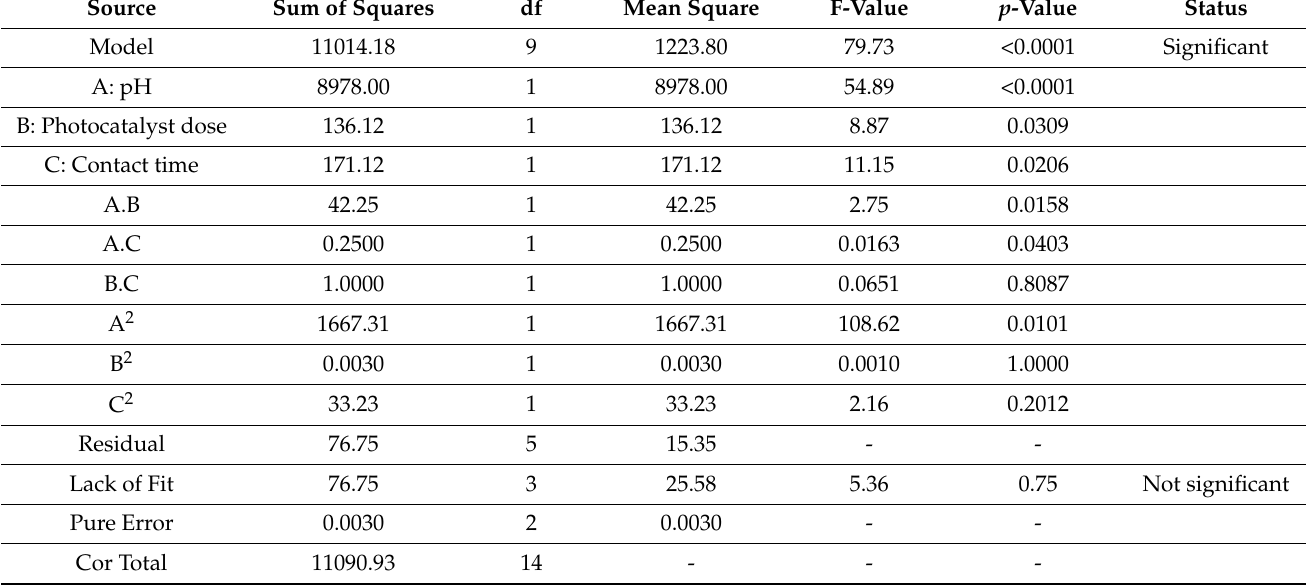
Table 7. An analyses of variance analysis of malathion